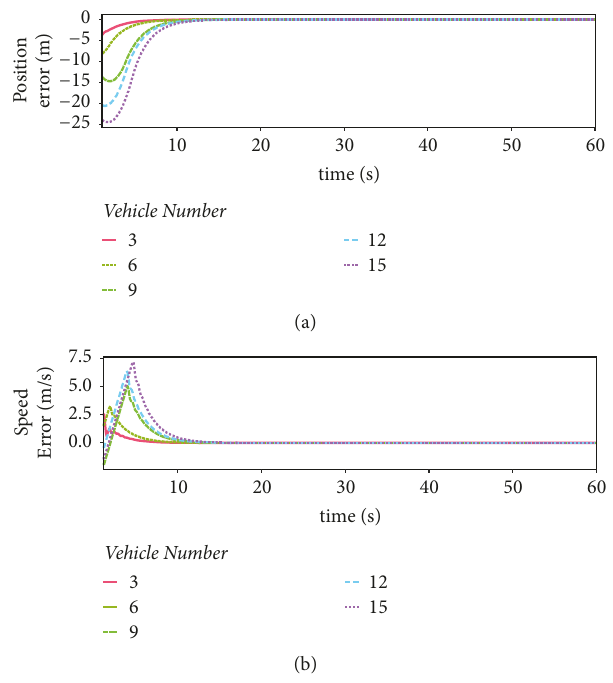
Figure6:Platoonperformanceinthepresenceoftheinitialscenario under different platoon lengths: (a) the position error 𝑥 𝑖 (𝑡)−𝑥 0 (𝑡)+ 𝑖 ⋅ 𝑠 ; (b) the speed error V